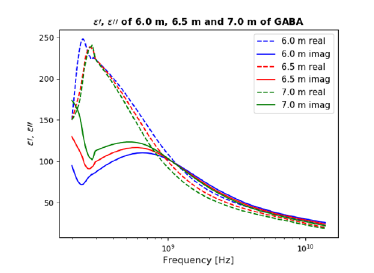
(a) Dielectric constant of 0.5 m - 6.0 m (b) Dielectric loss of 0.5 m -6.0 m GABA (c) Dielectric constant and dielectric loss GABA in deionized water at 37.5 °C. in deionized water at 37.5 °C. of 6.0 m, 6.5 m and 7.0 m of GABA solutions at 37.5 °C in a frequency range from 200 MHz to 14 GHz. Figure 2. Real ( ǫ ′ ) and imaginary ( ǫ ′′ ) parts of complex permittivity of GABA solutions and deionized water together with the fitted permittivity spectra as a function of frequency, at 37.5 ◦ C . GABA concentration ranges from 0.5 to 6.0 m with a 0.5 m step length between each of the concentrations. Dashed lines represent the experimental data points and solid lines represent the fitting to the relaxation model. Dielectric measurements were performed in a frequency range from 200 MHz–67